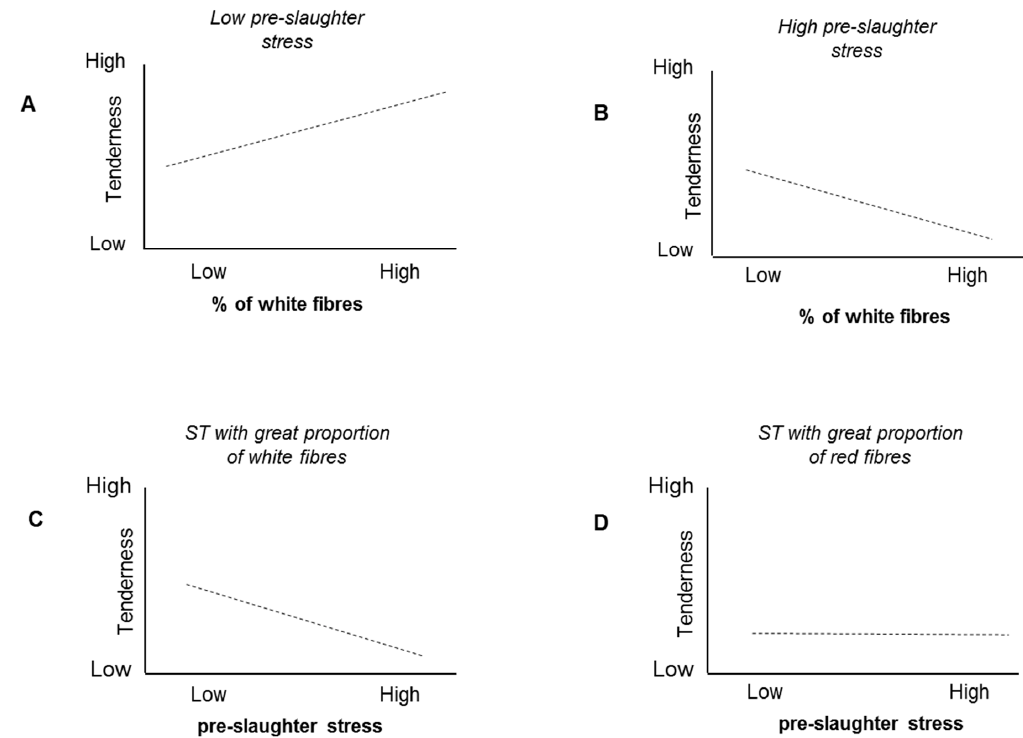
Figure 8. Illustration of the concept that correlations may be reversed if multiple factors are involved in a phenomenon. ( A ) Semitendinosus (ST) muscles containing greater proportions of white fibers have greater potential to produce good-quality meat [ 113 ], ( B , C ) but are also more sensitive to the negative effects of stress; ( B , D ) ST muscles containing a greater proportion of oxidative fiber types have less potential to produce good-quality meat but are less sensitive to preslaughter stress. In this example, if we compare low-stress and high-stress slaughter conditions, the correlation between fiber type composition and meat quality is reversed if the negative effects of stress outweigh the positive effects of a high proportion of white fibers ( A , B ). The composition of the muscle in terms of fiber type determines whether stress has a measurable impact on meat quality ( C , D ). High preslaughter stress will influence the postmortem metabolism of any muscle. Adapted from [ 61 ], with permission from INRAE, 2020.